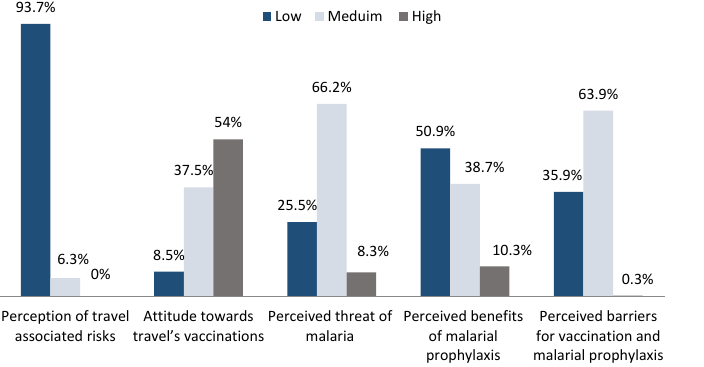
Figure 1. Distribution of Travelers at Cairo International Airport According to Level of Attitude About Travel-Associated Risks and Health Belief Model Perception About Malaria.